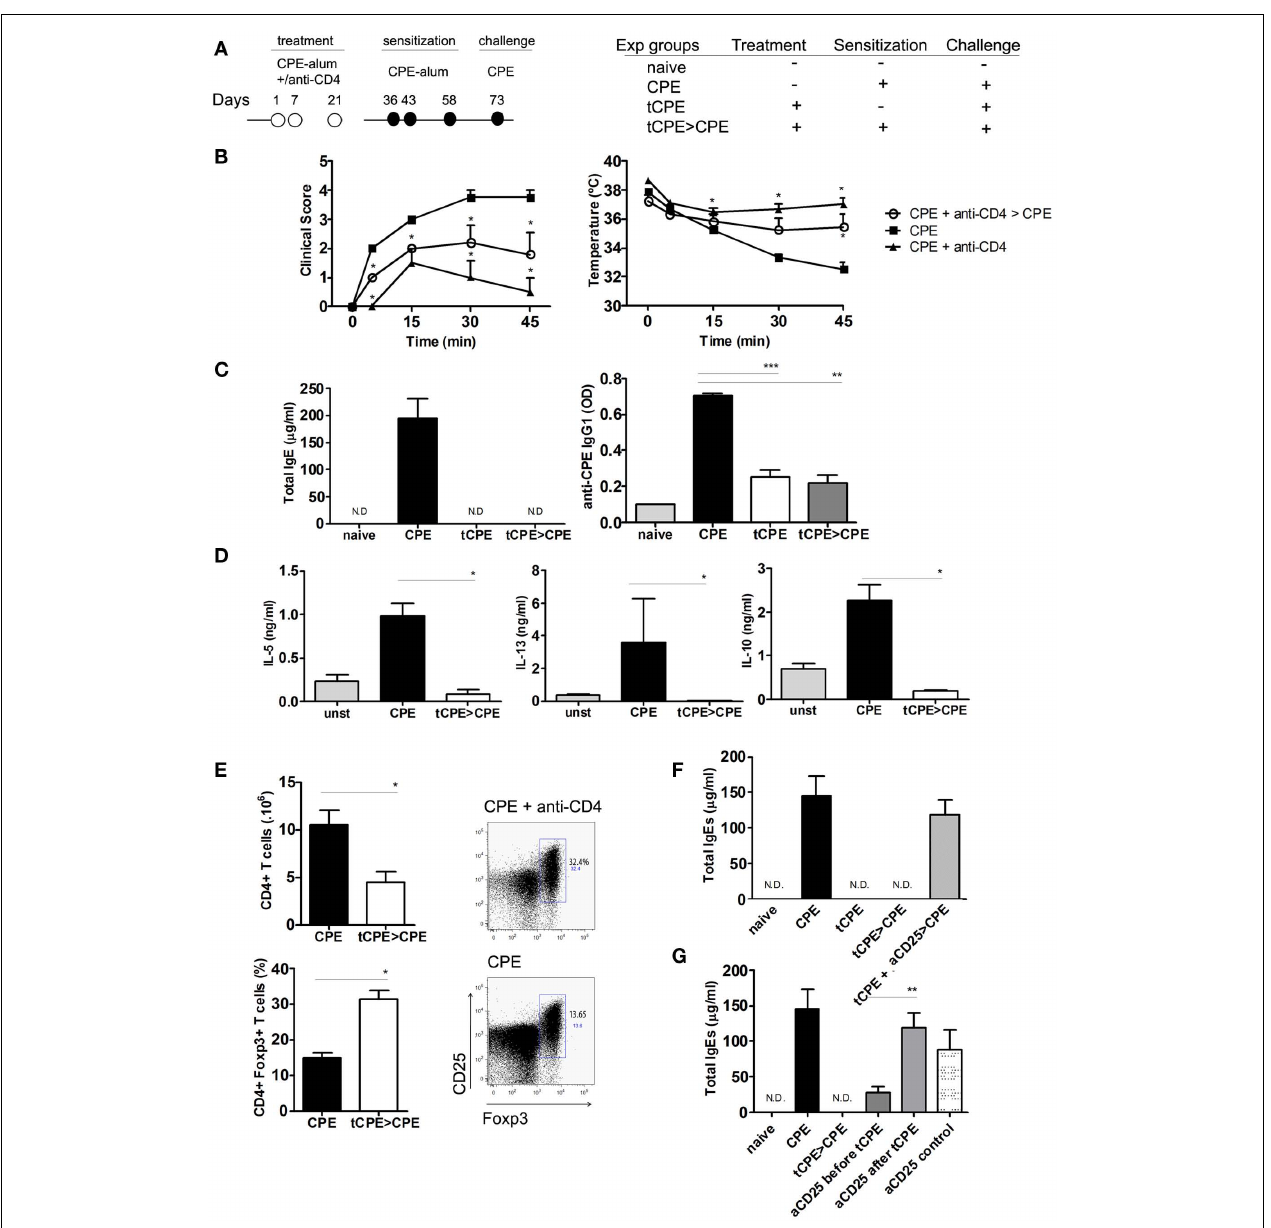
anti-CD4 treated mice following re-sensitization (tCPE > CPE) and significantly reduced compared with untreated mice ( n = 5, * P < 0.05). (E) The number of splenic CD4 + T cells was reduced in anti-CD4 treated mice, while the frequency of CD4 + Foxp3 + T cells was significantly higher ( n = 5, * P < 0.05). (F) C3H/HeJ mice were treated as described above, while some animals were depleted of CD25 cells at the time of anti-CD4 treatment (tCPE + aCD25 > CPE). CD25 depletion abrogated protection, leading to production of IgE to levels similar to mice not treated with anti-CD4. (G) We compared the effect of CD25 depletion before and after treatment with anti-CD4 (2 × 1mg, 10 and 8days before, or after tolerance induction with CPE + anti-CD4). Control mice were CD25-depleted before challenge with CPE, in the absence of treatment with anti-CD4 ( n = 5, * P < 0.05, ** P < 0.001, *** P < 0.001). Data (B–F) are representative of two independent